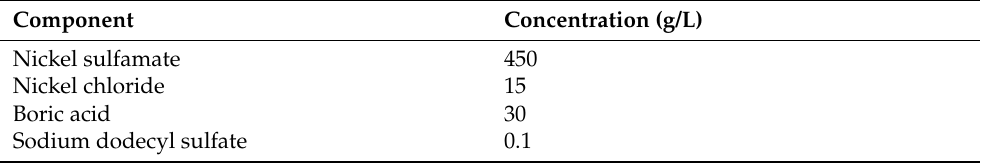
Table 1. Composition of the electrochemical deposition solution of pure nickel.